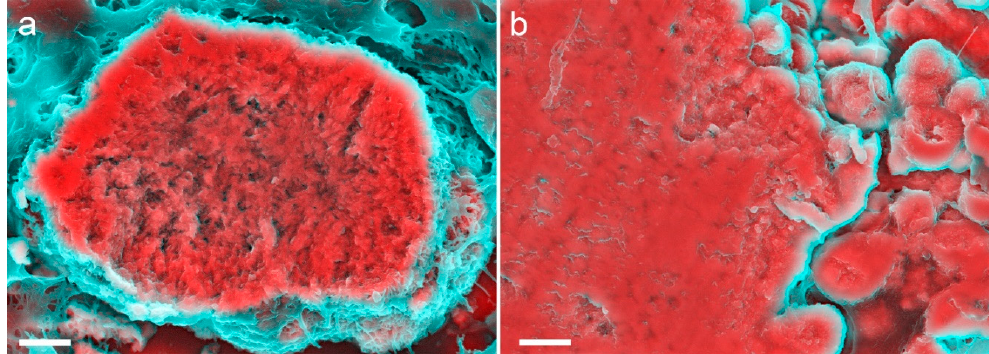
Figure 2. Density-dependent colour-scanning electron micrographs of breast microcalcifications. Red and pink indicate inorganic and turquoise (blue/green) indicates organic material. ( a ) Electron micrograph of a small microcalcification. ( b ) Electron micrograph of a larger microcalcification. Scale bars = 2 µm.